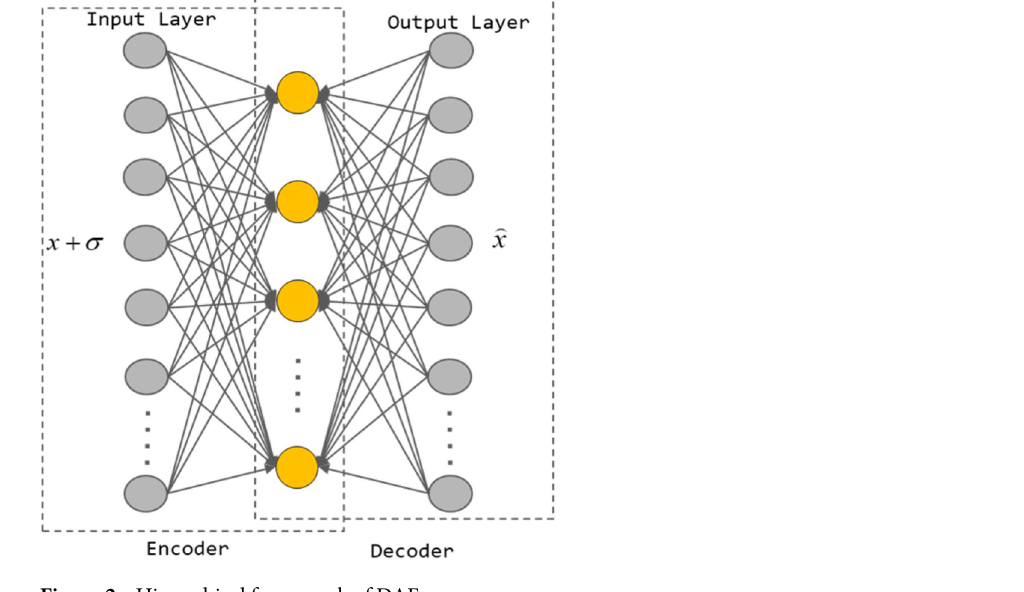
Figure 2. Hierarchical framework of